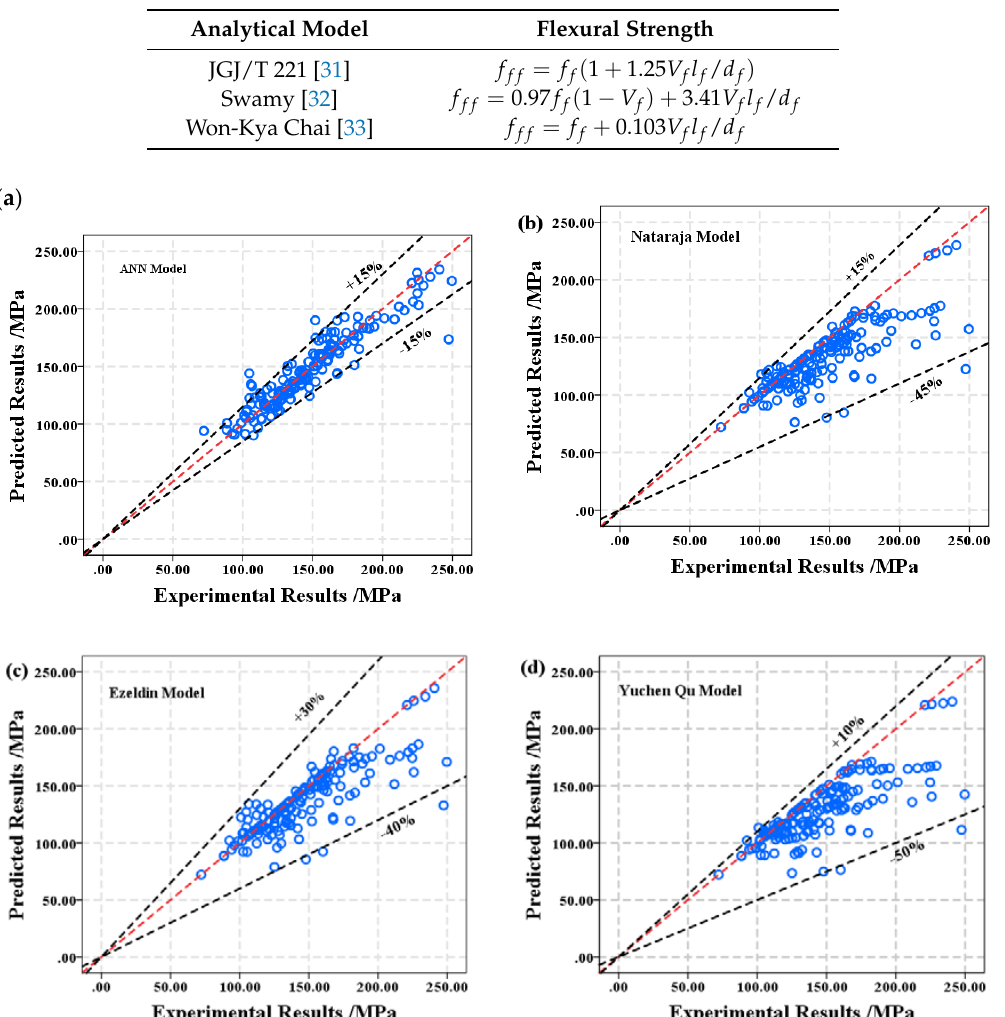
Figure 5. Comparison between predicted values and experimental values from three analytical models (proposed by Nataraja, Ezeldin, and Yuchen Qu) in previous studies and the ANN model studied in this paper. The 45 degree diagonal line (red line) denotes the predicted values equal to the experimental values and the black lines denote that the maximum ranges between predicted results and experimental results. Table 8. The Mean value, standard deviation (SD), and integral absolute error (IAE) of ANN model and analytical models.